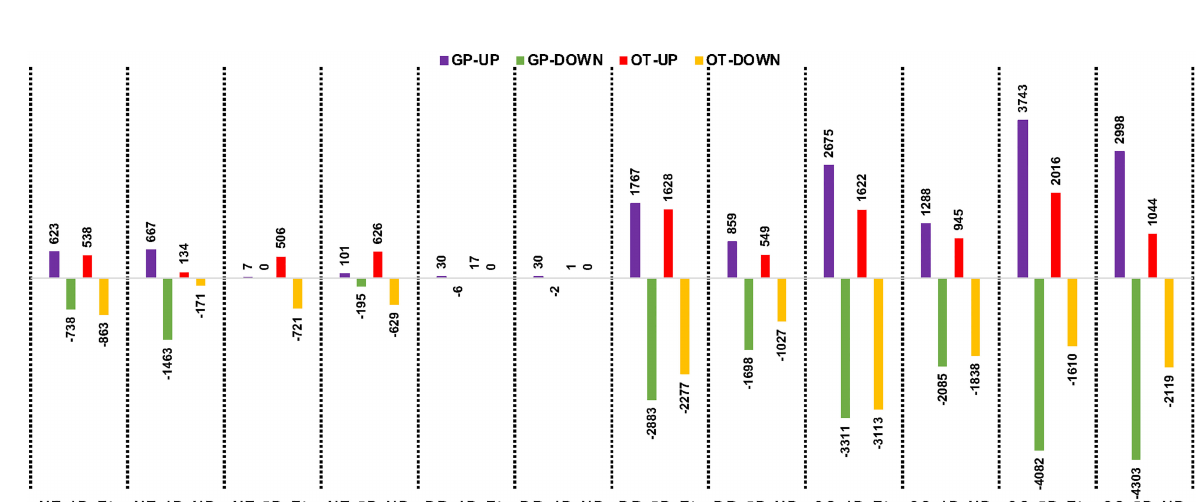
FIGURE 5 Number of differentially expressed genes in the fl ag leaf (FL) and head (HD) tissues at 1-day after stress (1D) or 5 days after stress (5D) in Golden Promise (GP) and Otis (OT) observed in response to heat (HT), drought (D), and combined stress (CS). Upward pointing bars represent upregulated genes and the downward facing bars represent the down regulated genes. Normalized counts for a gene from a stressed sample library is divided by the corresponding normalized counts for the same gene from the matched control sample library. A log 2 > 1.0 and FDR of 0.05 was used as the cutoff to call a gene as being differentially